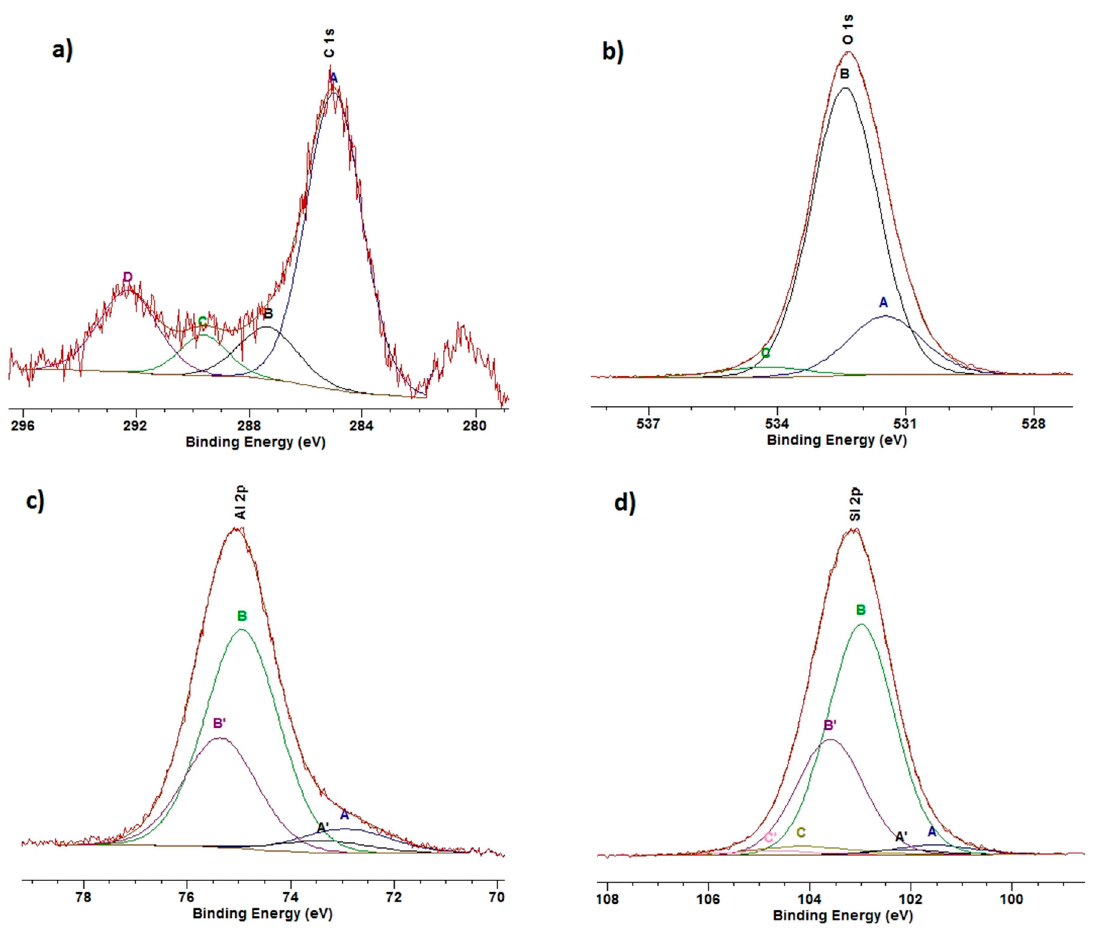
Figure 4. High-resolution XP spectra of Na-M: ( a ) C 1s, ( b ) O 1s, ( c ) Al 2p, ( d ) Si 2p.